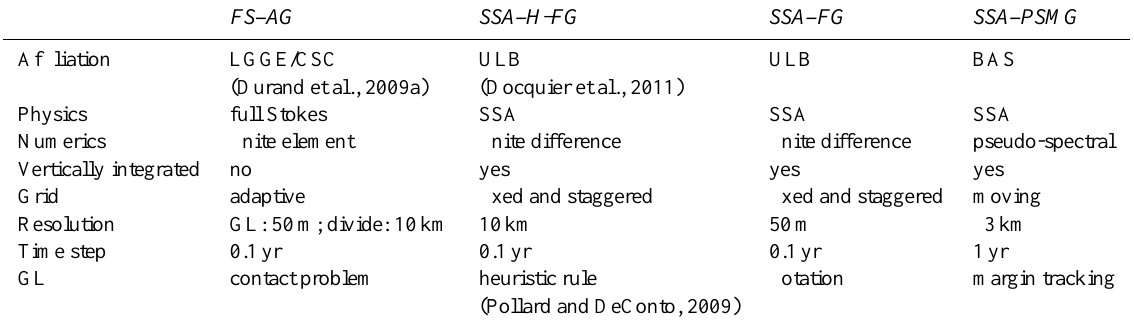
Table 1. Summary table of model characteristics: LGGE/CSC stands for Laboratoire de l’Environnement, CSC for CSC-IT Center for Science, ULB for Universit´e Libre de Bruxelles, and BAS for British Antarctic